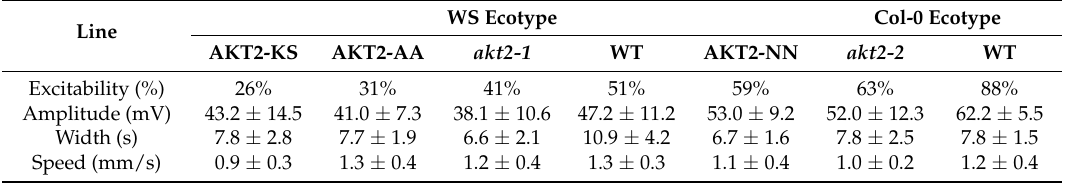
Table 2. Numerical data for action potentials (APs) recorded in electrically-stimulated wildtype and AKT2 mutants of WS and Col-0 ecotypes. Knockout mutants were compared to their respective wildtype (WT), akt2-1 for WS and akt2-2 for Col-0. The other studied AKT2 mutant lines were all of the WS ecotype, expressing, in the WS akt2-1 knockout background, modified AKT2 channels carrying either a single K198S substitution (WS AKT2-KS), double substitutions S210A-S329A (WS AKT2-AA) or S210N-S329N (WS AKT2-NN). Excitability was taken as the number of plants (of the